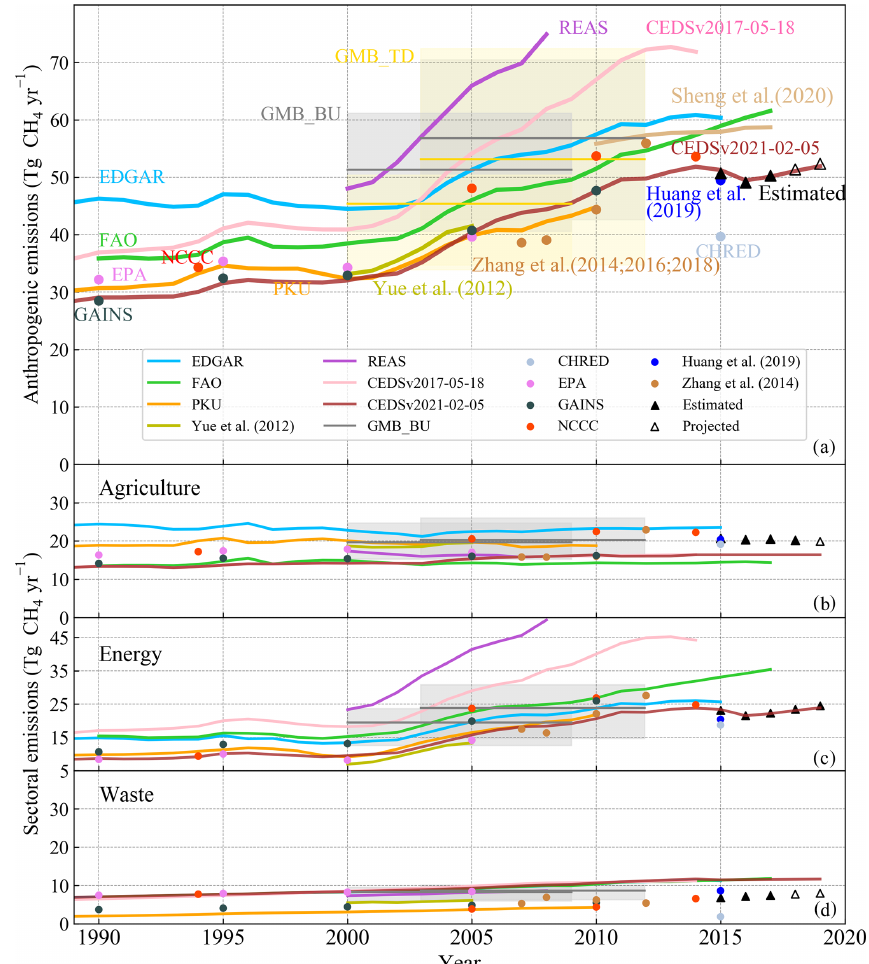
Figure 1. The temporal variation in China’s total (a) and sector-specific (c–d) CH 4 emissions since 1990. Gray and yellow lines indicate the mean of the bottom-up and top-down estimates of CH 4 emissions from the GMB, respectively. Shaded areas represent the min and max value of emissions from the GMB. The emissions from 2015 to 2019 in this study (black triangles) refer to estimates using national activity data from the NBS and localized emission factors from the NCCC. Note that the empty triangle indicates projected values using the trend over the last 5